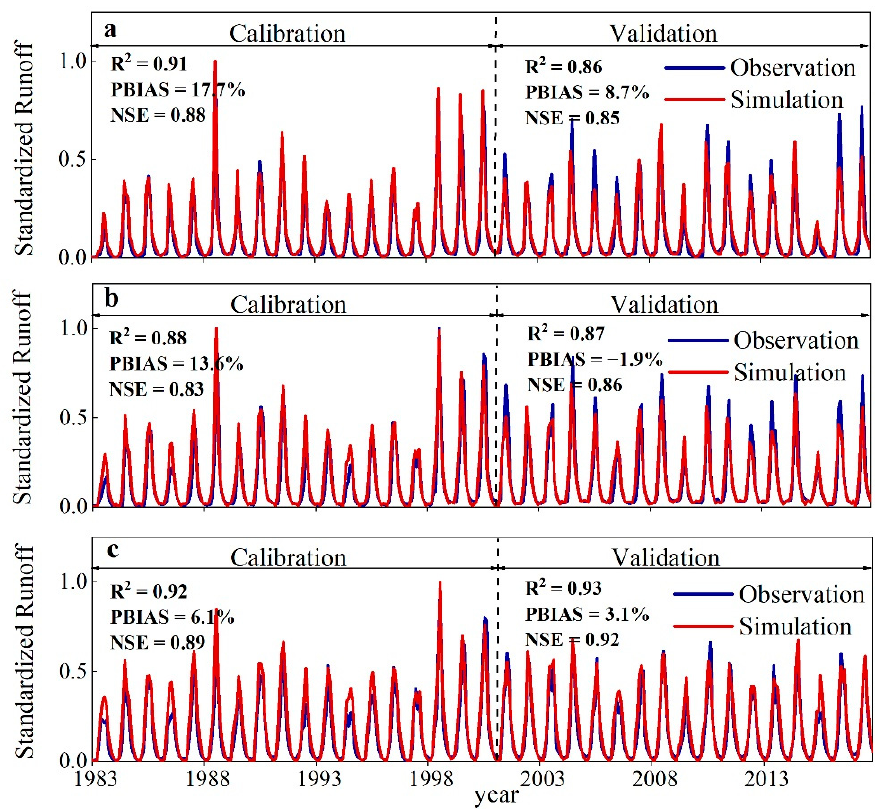
Figure 2. Simulated and observed (MODIS) for ( a ) monthly and ( b ) multi-year monthly average snow cover area of the study area during 2001–2017.